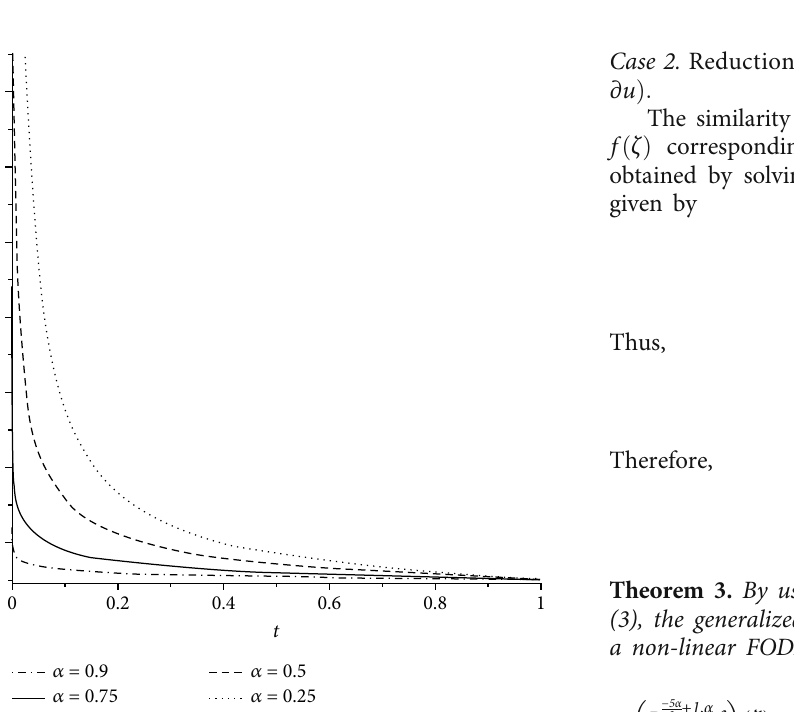
x , t Þ for Eq. (1) for K 1 ð